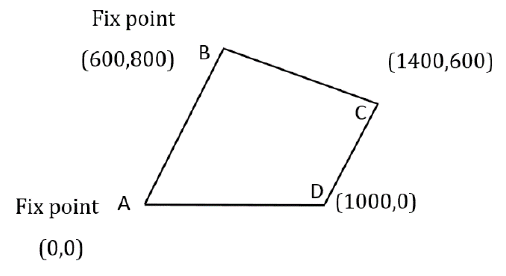
Figure 4. The irregular quadrilateral